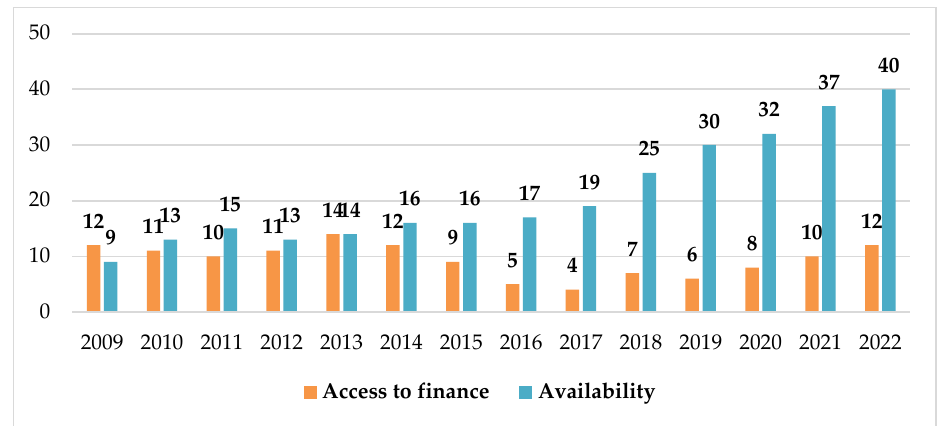
Figure 7. Most significant problems faced by euro area firms (weighted percentage of respondents). Source: Adapted from Ref. [77].